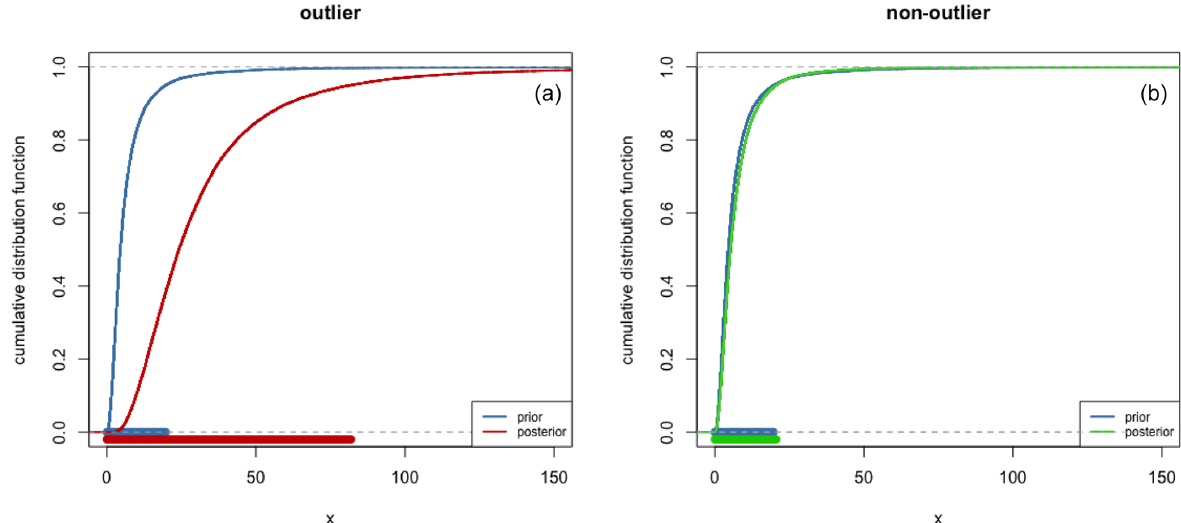
Figure 1. Comparison of prior and posterior cumulative distribution functions of individual variance and their 95% credible interval (bottom horizontal lines): the corresponding equivalent dose is detected as an outlier (a) or not (b)